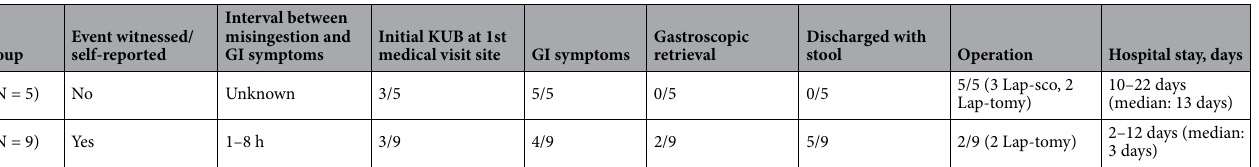
Table 3. Comparison of unwitnessed/non-self-reported magnetic foreign body misingestion (Group 1) and witnessed/self-reported magnetic foreign body misingestion (Group 2) in